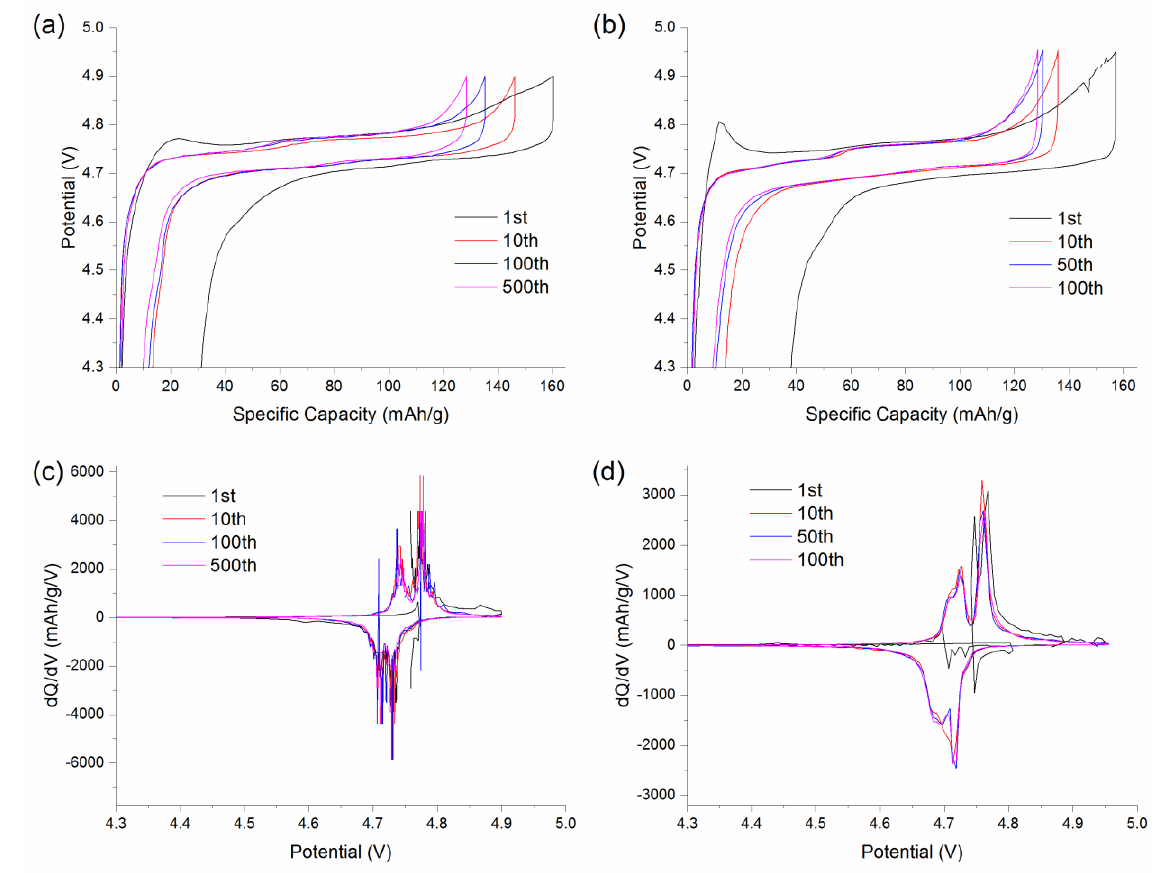
Figure 8. Charge/discharge and dQ/dV curves for LMNTO ( a , c ) and LMNO ( b , d ) materials. The dQ/dV plot for the data is replotted in Figure 8c. In addition to clearly demon- To study the influence of C-rate and temperature on battery performance, LMNTO strating the lack of redox behavior in the 4 V region, it shows that the redox behavior at and LMNO were tested at different C-rates and temperatures as shown in Figure 9. It can 4.7 V is still split up to 100 cycles. It also shows good capacity retention up to 500 cycles be seen that for both room temperature and 60 °C higher C-rate, up to 10C, reduces the with little change in voltage profile or capacity after the 100th cycle. A notable change in capacity and the capacity recovers back when C-rate was lowered back to C/2. The specific dQ/dV vs. V plot from 1st cycle to later cycles is observed, which may be the indication discharge capacity of LMNO were 102, 93, 74, 36 and 4 mAh/g at C/2, 1C, 2C, 5C and 10C, of a formation reaction occurring on 1st cycle that is distinguished in discharge profile. respectively, and for LMNTO were 110, 101, 86, 50 and 10 mAh/g at C/2, 1C, 2C, 5C and 10C, respectively. At 60 °C, the capacity was higher than the room temperature one for all C-rates, however, the coulombic efficiency was lower, 98% for room temperature and 89% in Figure for 60 °C, respectively.